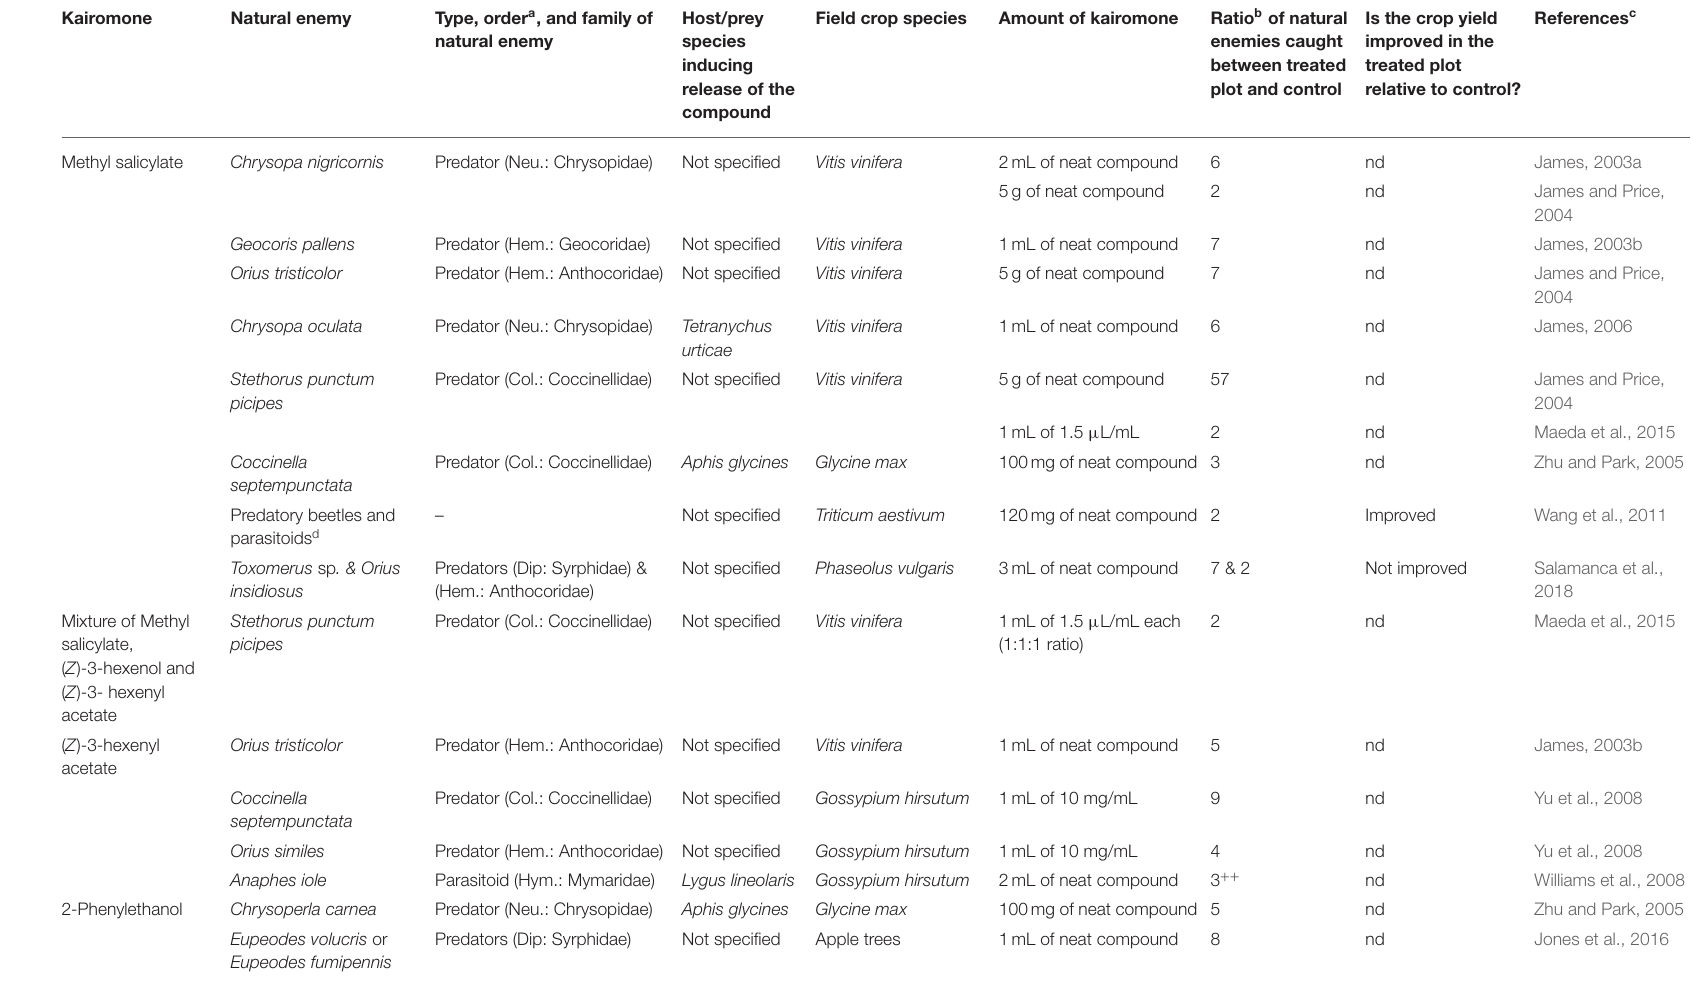
TABLE 1 | Summary of some synthetic herbivore-induced plant volatiles applied in fields to attract natural enemies.